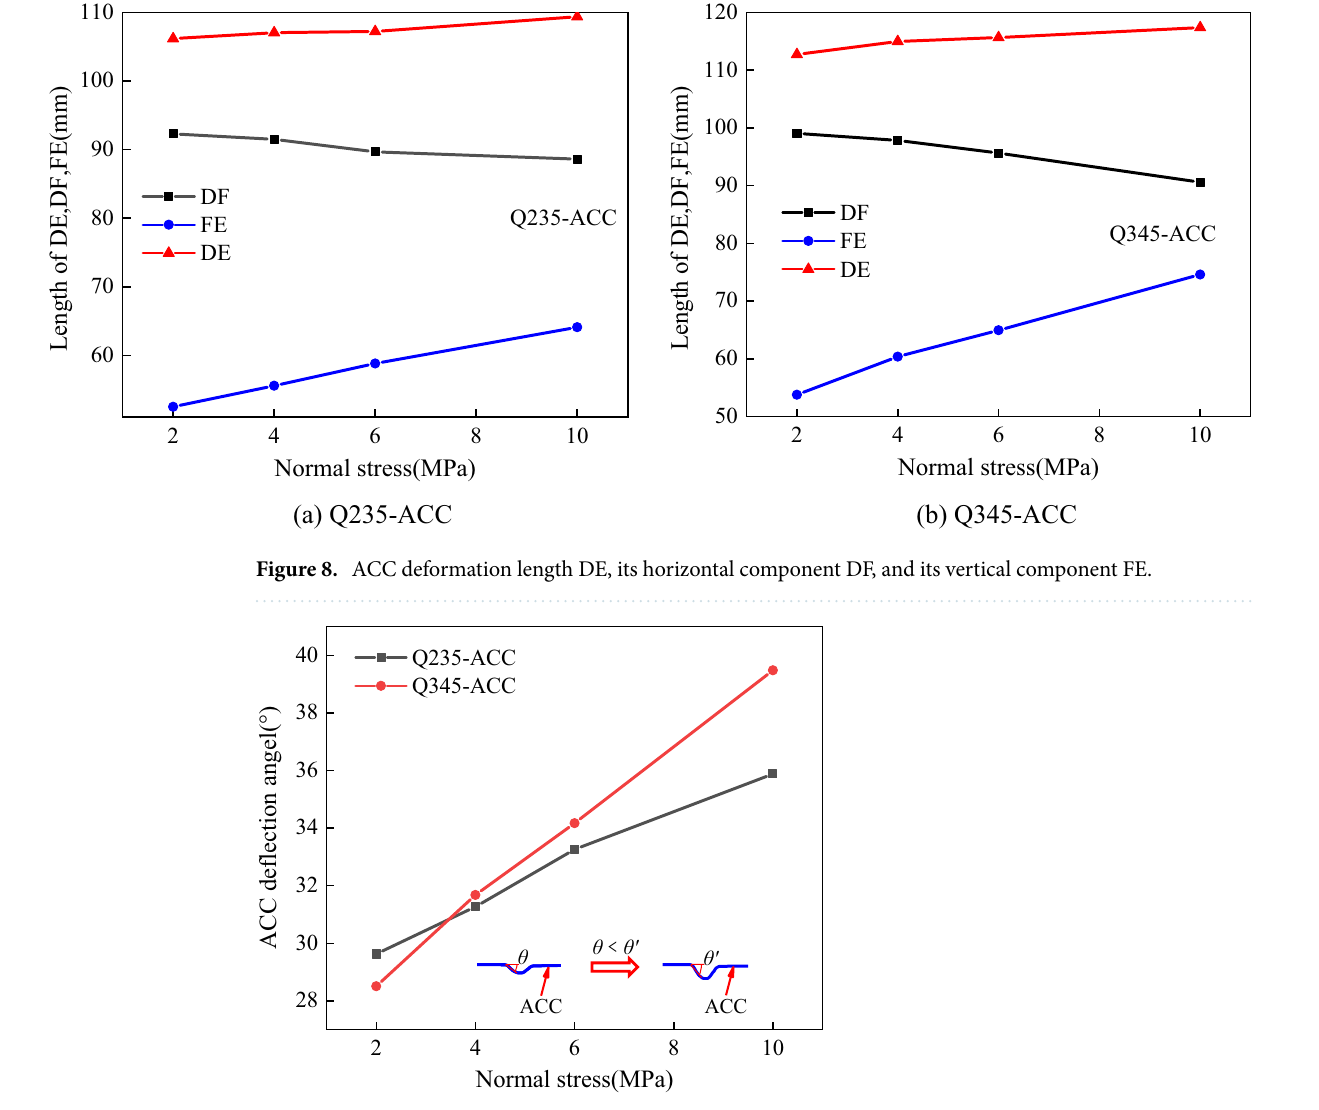
Figure 9. Relationship between the plastic hinge angle θ of the ACC and σ n